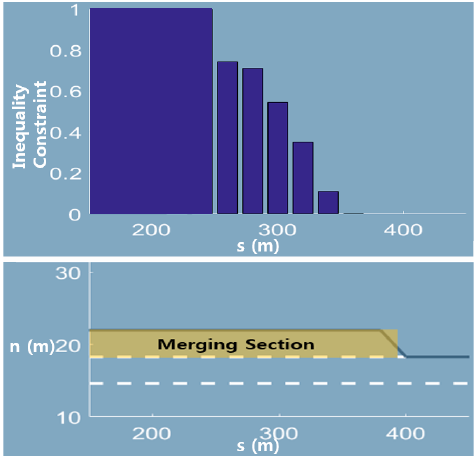
Figure 9. Merging section of I-101 and inequality constraints. The upper plot presents the inequality